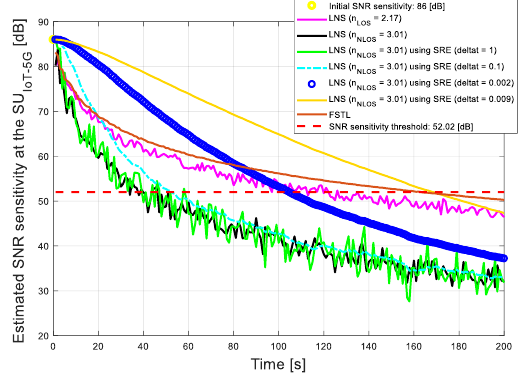
Figure 5 . Estimated SNR sensitivity at the SU IoT-5G vs. Time [s].